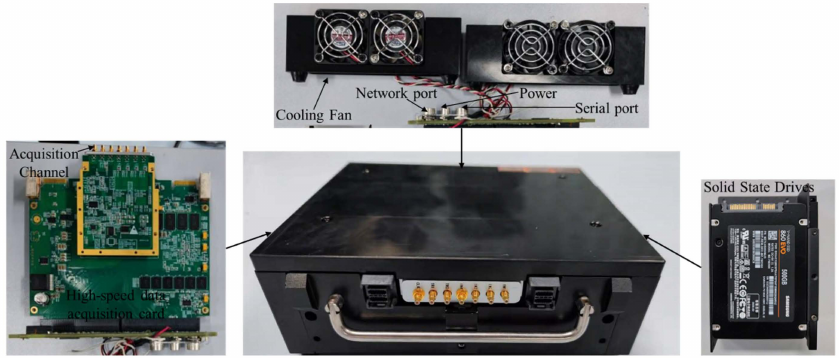
Figure 14. High-speed AD sampling module.